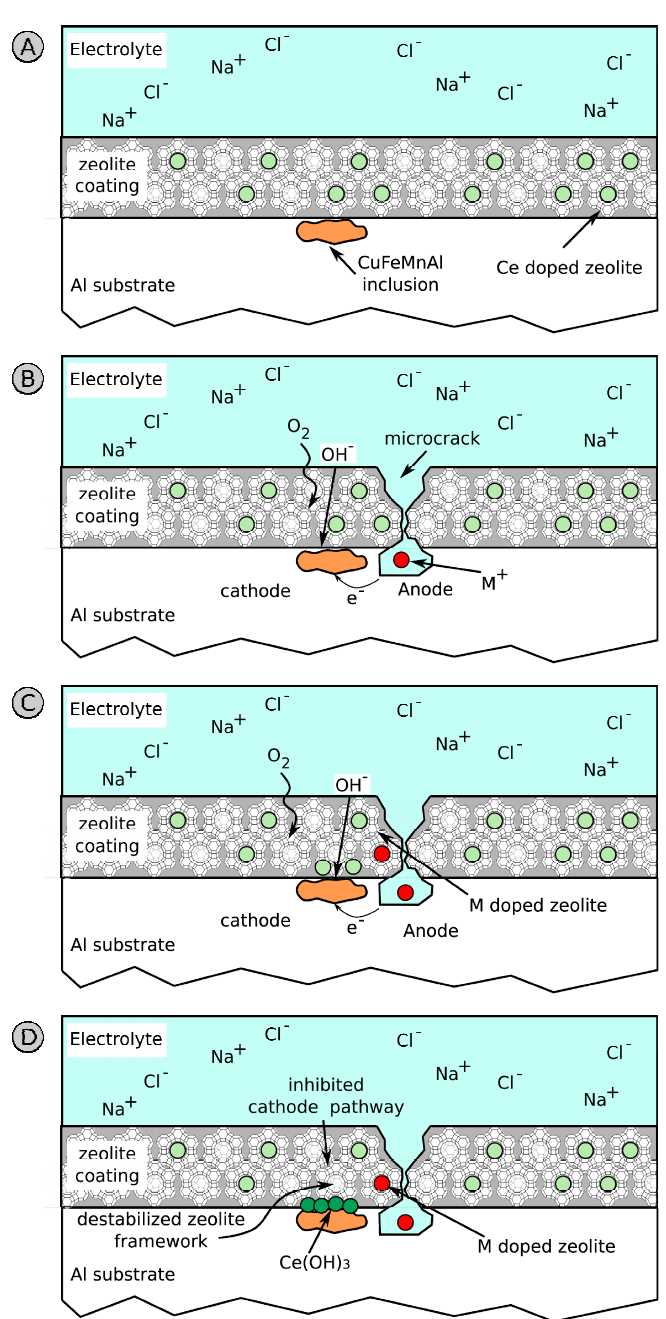
Figure 11. Scheme of the self-healing process of Ce doped zeolite coatings. ( A ) Zeolite coated substrate. ( B ) Intermetallic inclusion contribute on anode/cathode reactions. ( C ) Ion exchange process and cathodic zeolite destabilization for the release of Ce 3+ . ( D ) Precipitation of Ce oxide/hydroxide on intermetallic